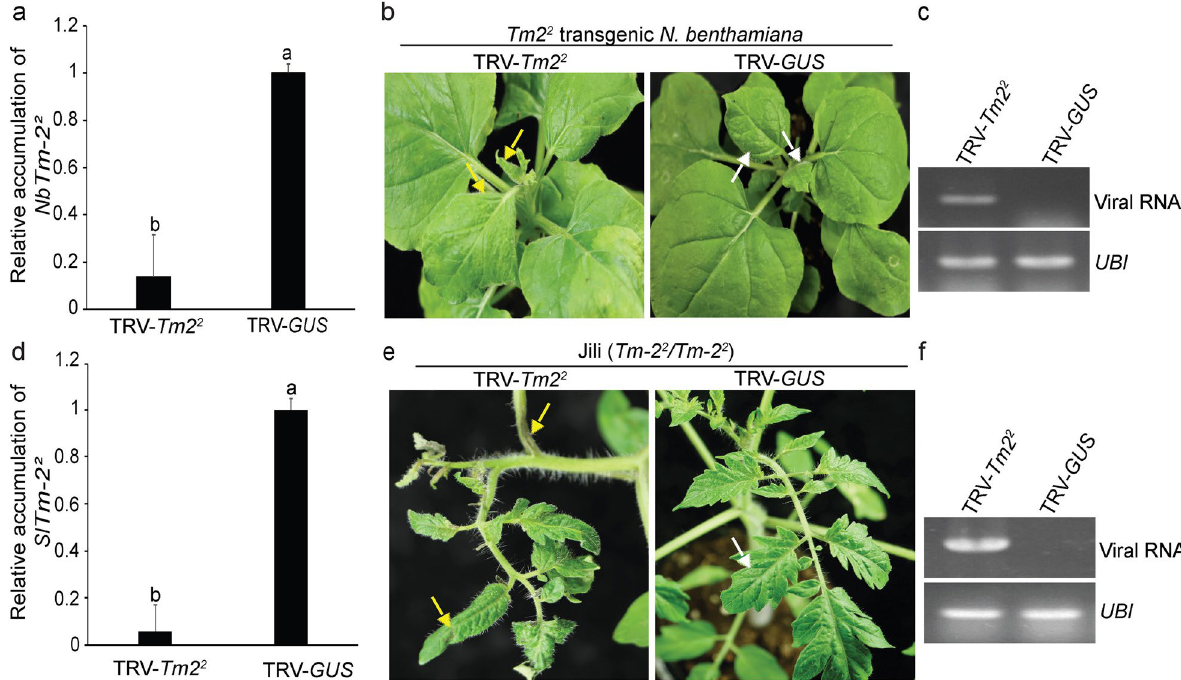
Fig. 4 Effects of Tm-2 2 accumulation on the disease resistance against ToMMV. a RT‑qPCR analysis of the Tm-2 2 mRNA accumulation levels in the silenced and control Tm-2 2 transgenic Nicotiana benthamiana plants inoculated with TRV‑derived vector at 10 days post‑agro‑infiltration (dpai). Yellow arrows show symptomatic systemic leaves and white arrows show asymptomatic systemic leaves. b The symptoms of Tm-2 2 - silenced and the control Tm-2 2 transgenic N. benthamiana plants inoculated with ToMMV at 7 dpai. c RT‑PCR detection of ToMMV RNA in the systemic leaves of the silenced and the control Tm-2 2 transgenic N. benthamiana plants. d RT‑qPCR analysis of Tm-2 2 mRNA accumulation levels in the silenced and the control tomato cultivar Jili inoculated TRV‑derived vector at 10 dpai. e The symptoms of Tm-2 2 - silenced and control Jili tomato plants inoculated Jili. The mRNA accumulation of the UBI gene served as an internal control. The values indicate the mean SD of three biological replicates. Letters + indicate significant differences in different treatments ( P <